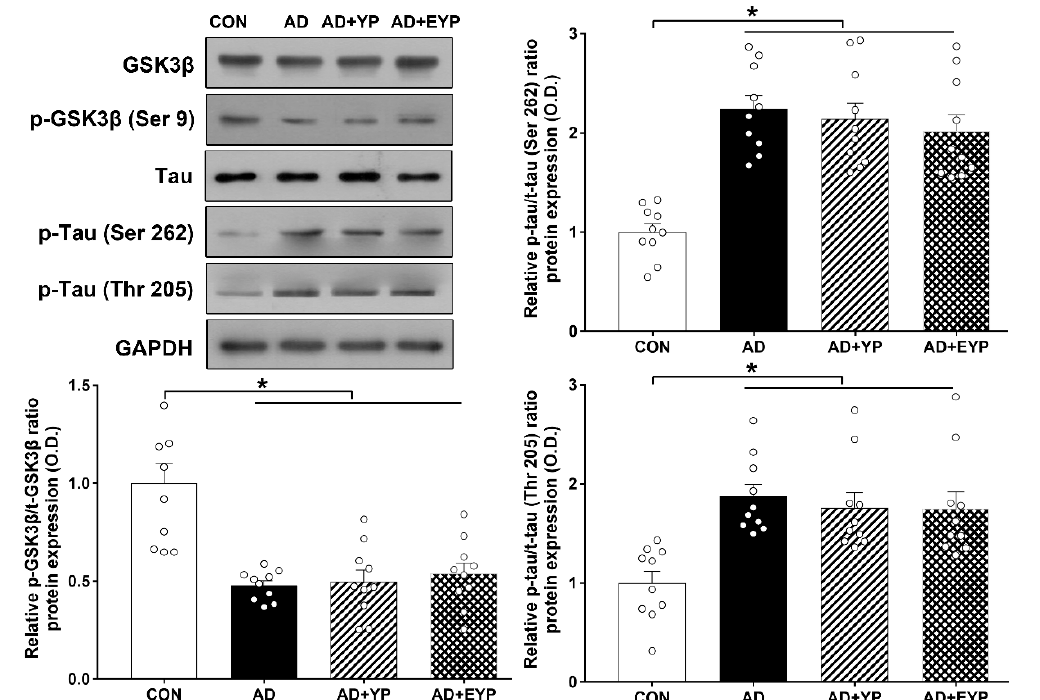
Figure 3. Effect of plasma from young exercised mice on GSK3 β and tau protein expression in the hippocampus. CON: wild-type, AD: 3xTg-AD, AD + YP: 3xTg-AD and young plasma injection, AD + EYP: 3xTg-AD and exercised young plasma injection group. Data are expressed as the mean ± standard error of the mean (SEM). * p < 0.05 compared with the CON group.